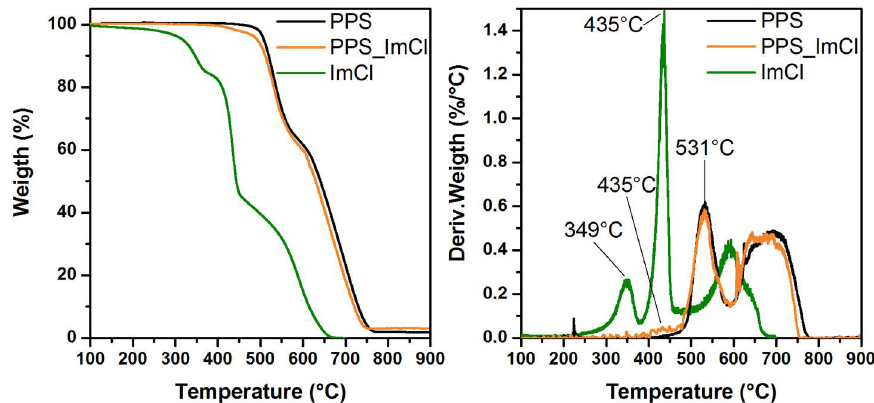
Figure 3. Weight loss and derivative of the weight loss as a function of temperature for PPS (black line), PPS_ImCl (orange line), ImCl (green line).